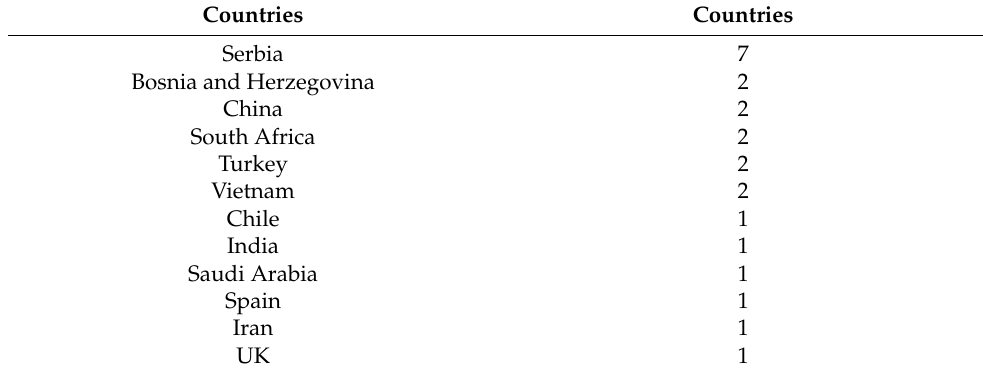
Table 1. Publications by country.